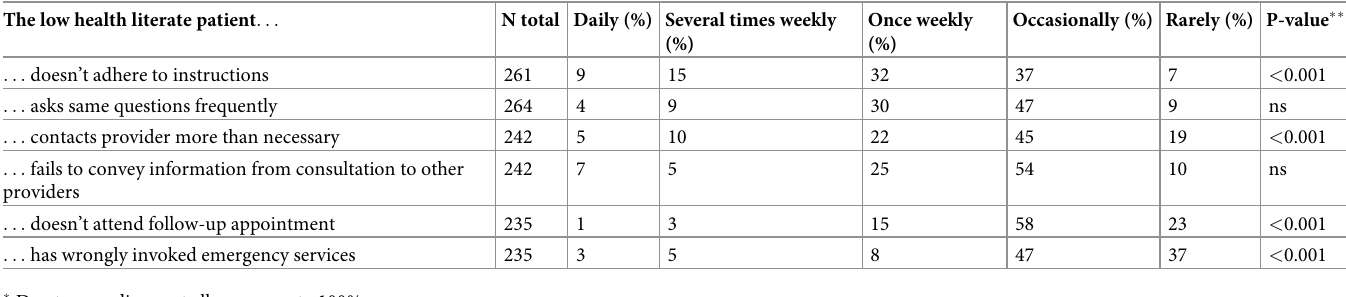
Table 5. Challenges with low health literate patients following a consultation � . The low health literate patient